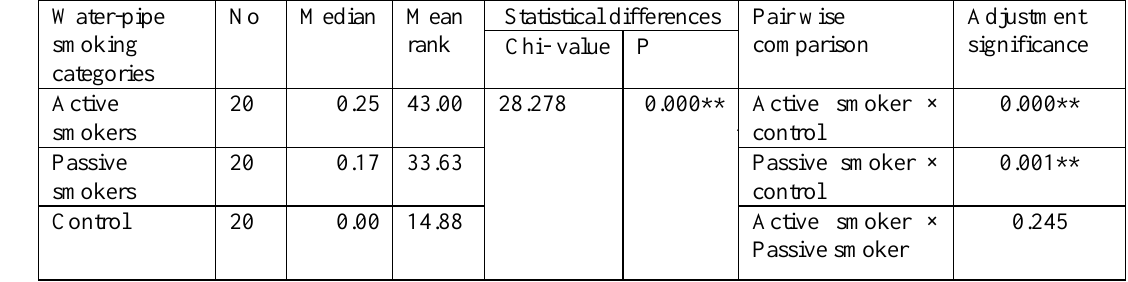
Table 2: Calculus index (Median, Mean Rank) among water-pipe smokers in comparison to control group.